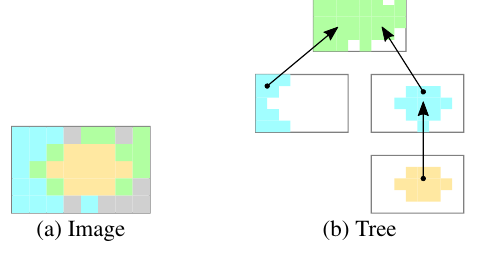
Figure 4. Perimeter data structure